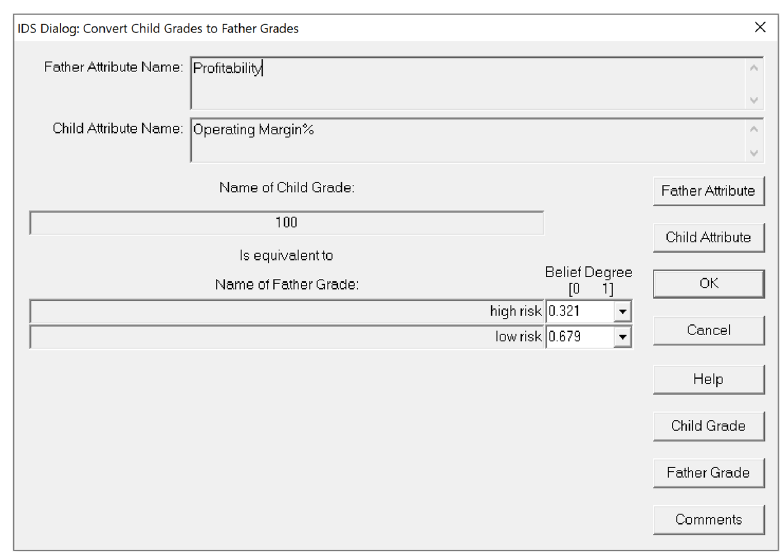
Figure 3. Converting child grades to father grades by rule-based approach.